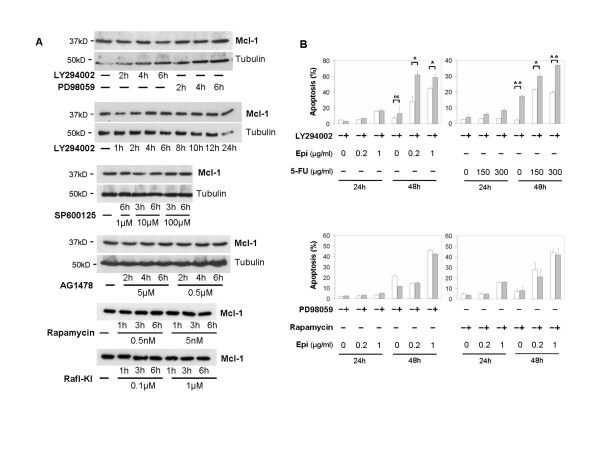
Blocking of different protein kinases and its effect on Mcl-1 expression and chemotherapeutic drug-induced apoptosis. (A) Huh7 cells were treated with the kinase inhibitors LY294002 (25 μM, blocking PI3 kinase), PD98059 (50 μM, blocking MEK1), SP600125 (1–100 μM, blocking JNK1), AG1478 (0.5–5 μM, blocking EGF receptor tyrosine kinase), rapamycin (50 pM, blocking mTOR kinase) and Raf I-kinase inhibitor (0.1–1 μM) for the time indicated. Whole cell lysates were prepared, separated, and immunoblotted with antibodies against Mcl-1 and alpha-tubulin. Blots shown are representative for at least two independent experiments. (B) Huh7 cells were treated with LY294002 (25 μM), PD98059 (50 μM), rapamycin (50 pM). After 1 h of pre-incubation, cells were additionally treated with epirubicin, 5-FU or left untreated for 24 h (concentrations as indicated). Cells were then harvested and analyzed by flow cytometry for apoptosis induction according to Nicoletti et al. [29]. Assays were performed in triplicates and are representative for three independent experiments. Values are means + SD. *p < 0.01, **p < 0.001.